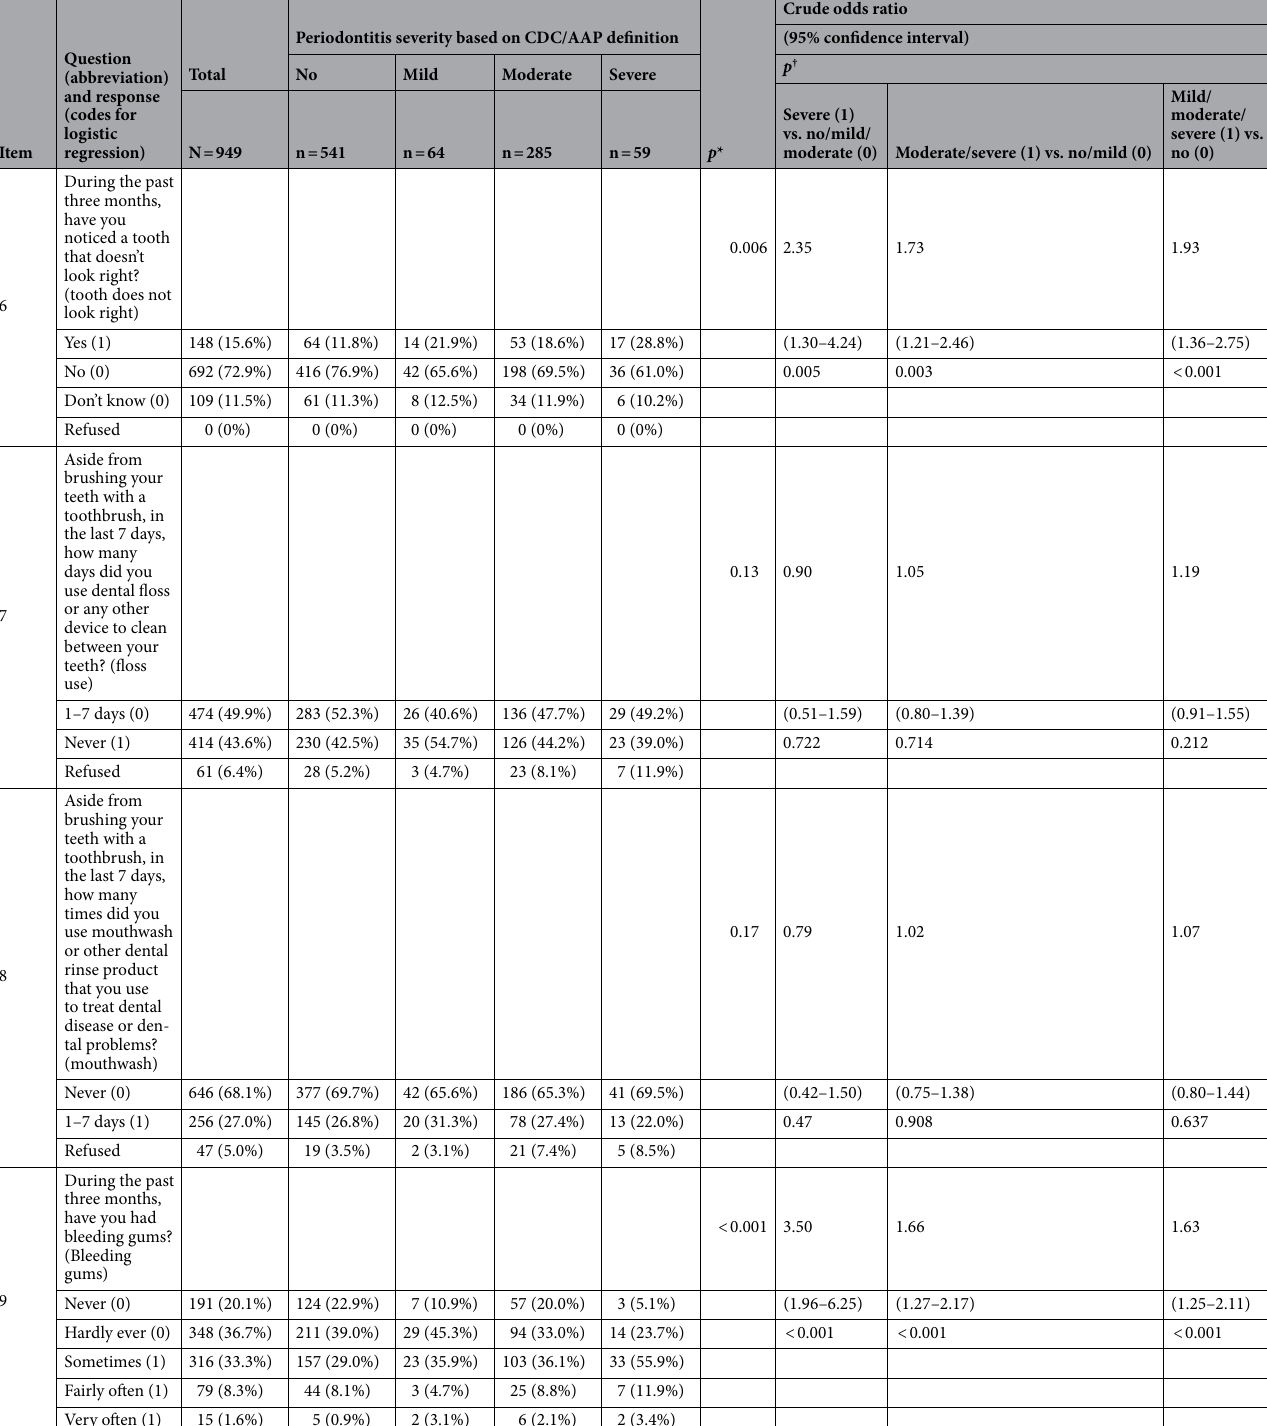
Table 2. Responses to questions stratified by periodontitis status among Japanese adults (N = 949). AAP, American Academy of Periodontology; CDC, Centers for Disease Control and Prevention. * p -value for the chi-squared test for the association between periodontal classification and responses to questions. † p -value for the logistic regression analyses for the association between periodontal classification and responses to